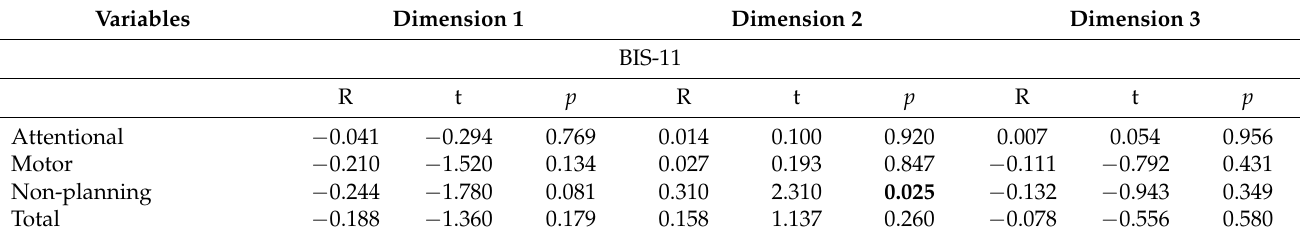
Table 4. Correlation of the HDRS dimensions (dimension 1, 2, 3) with clinical